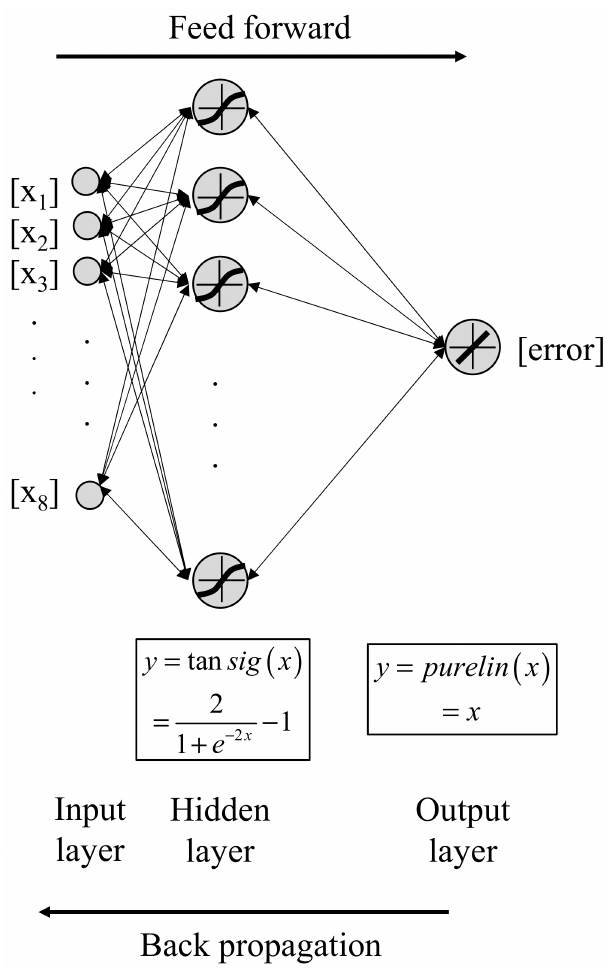
Figure 3. Architecture of the feedforward ANN with backpropagation that is used in the present